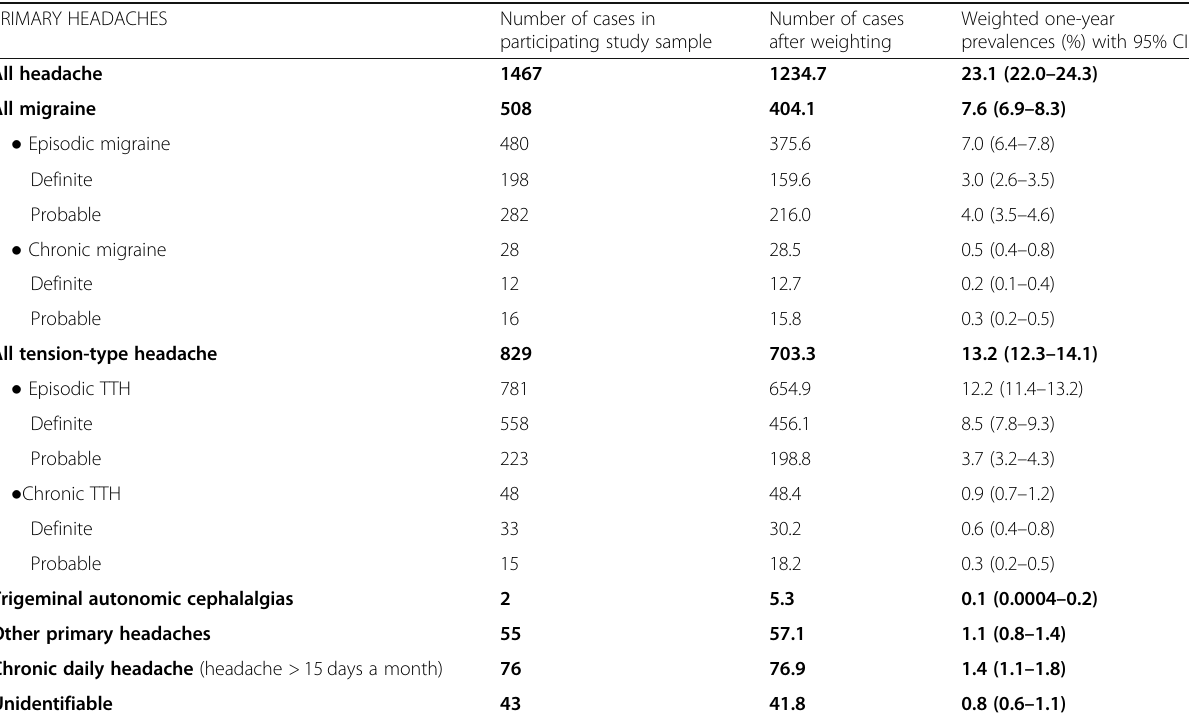
Table 2 Weighted one-year prevalences of primary headaches in the online study